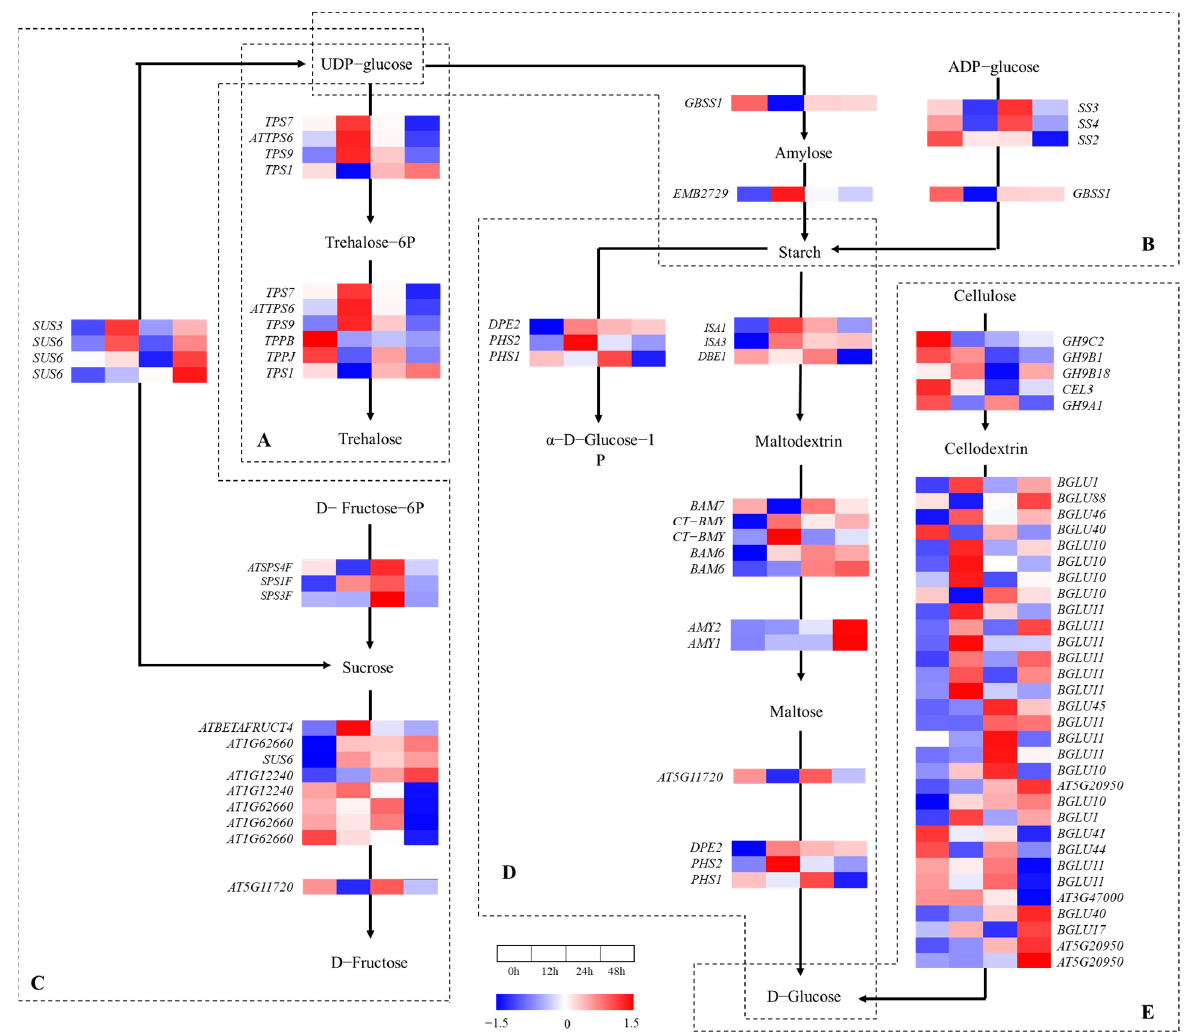
Figure 6. Heat map of annotated genes in starch and sucrose metabolism pathway. Solid lines and arrows represent biological processes and directions, while areas separated by dotted lines represent different types of biological processes. ( A ) Trehalose synthesis process; ( B ) starch synthesis process; ( C ) sucrose synthesis and hydrolysis process; ( D ) starch hydrolysis process; ( E ) cellulose hydrolysis process.